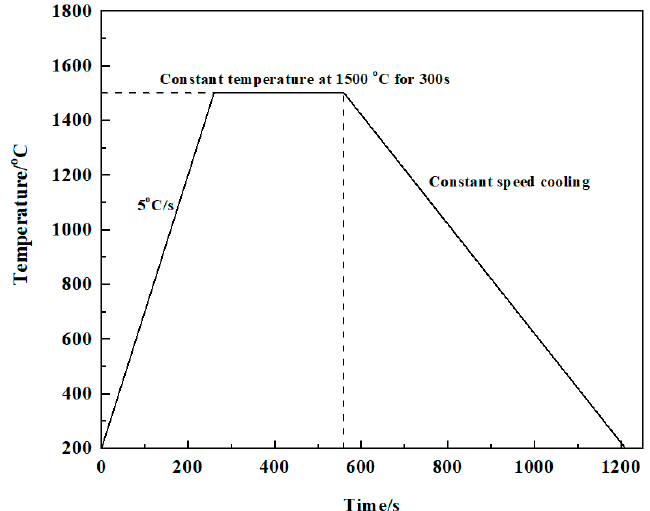
Figure 2. Schematic diagram of the temperature during the continuous cooling test.